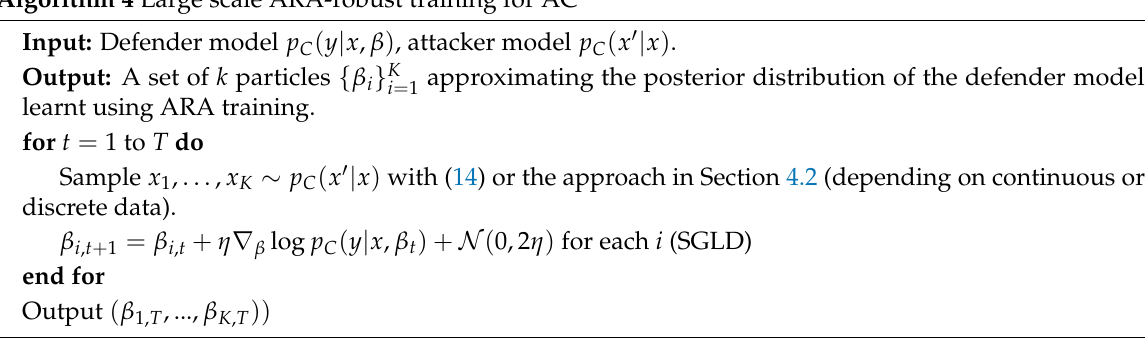
Algorithm 4 Large scale ARA-robust training for